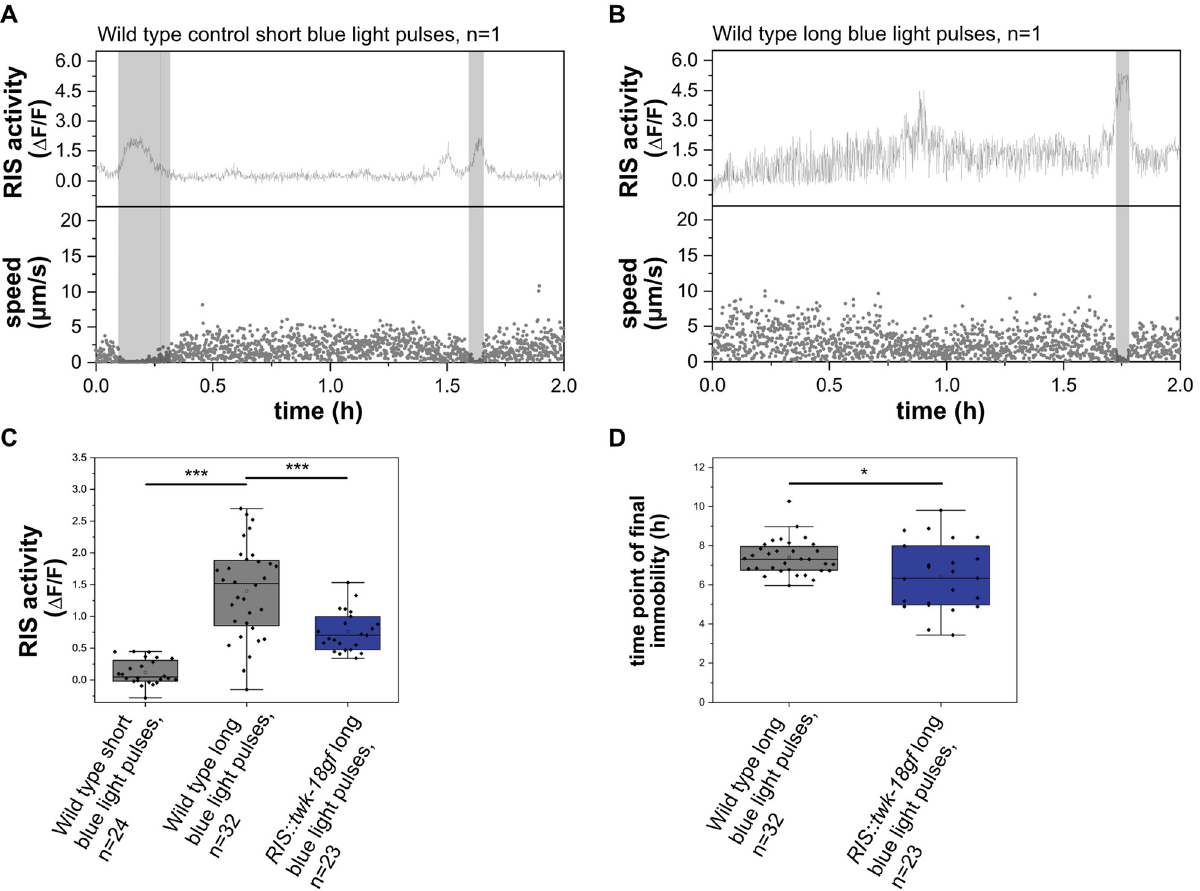
Fig 11. RIS activates upon lethal blue-light stimulation and extends survival. A) Sample trace for a control worm stimulated by a short blue light stimulus. RIS speed was measured. B) Sample traces of wild-type worms upon stimulation with a long blue-light stimulus. The grey shaded area presents detected time in motion quiescence. C) The strong stimulus increased normalized RIS activity over baseline compared to control worms. ��� p < 0.001, Welch test. D) Wild-type worms have a survival advantage over RIS-inhibited worms upon exposure to the lethal blue-light stimulus. � p < 0.05, Welch